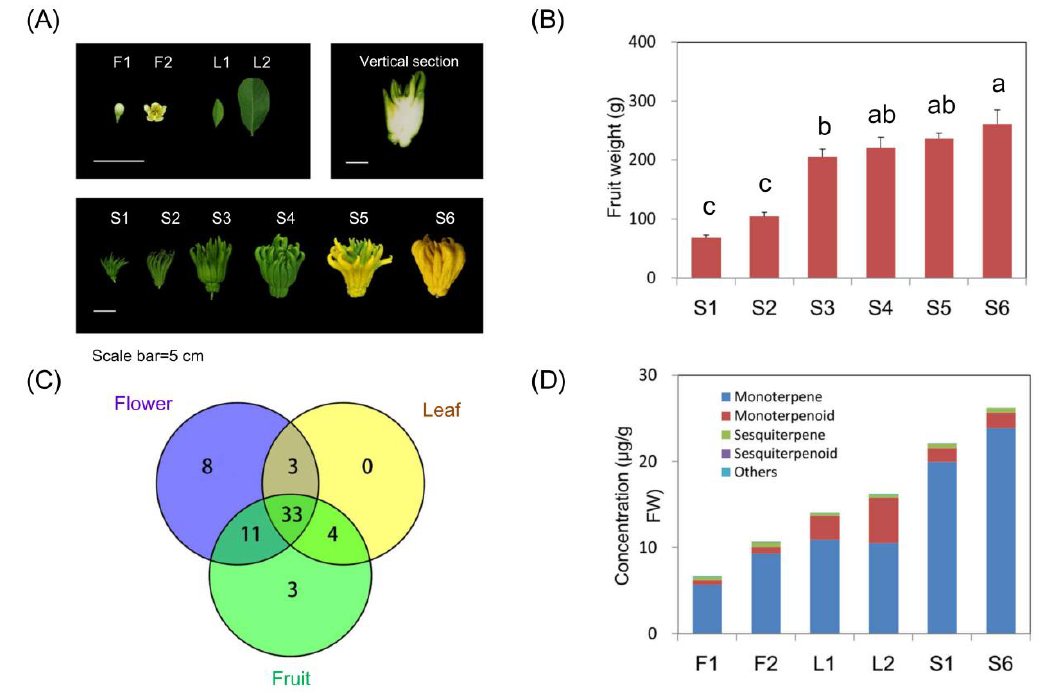
Figure 1. Major volatile classes from finger citron. ( A ) Photos of flower, leaf and fruit. ( B ) Changes in fruit weight during ripening. ( C ) Venn diagram of volatiles detected in three organs. ( D ) Concentration of major volatile classes in developing organs. F1, flower bud; F2, full flower, L1, young leaf; L2, mature leaf; S1–6, fruit developing stages 1–6. Scale bar = 5 cm. Significant di ff erences between groups were detected by Duncan’s test at significant level of